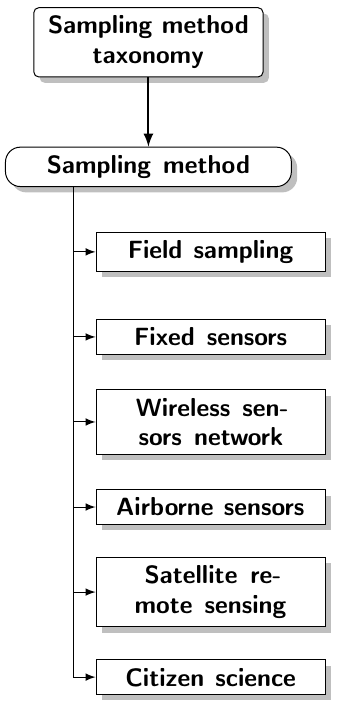
Figure 1. Sampling method